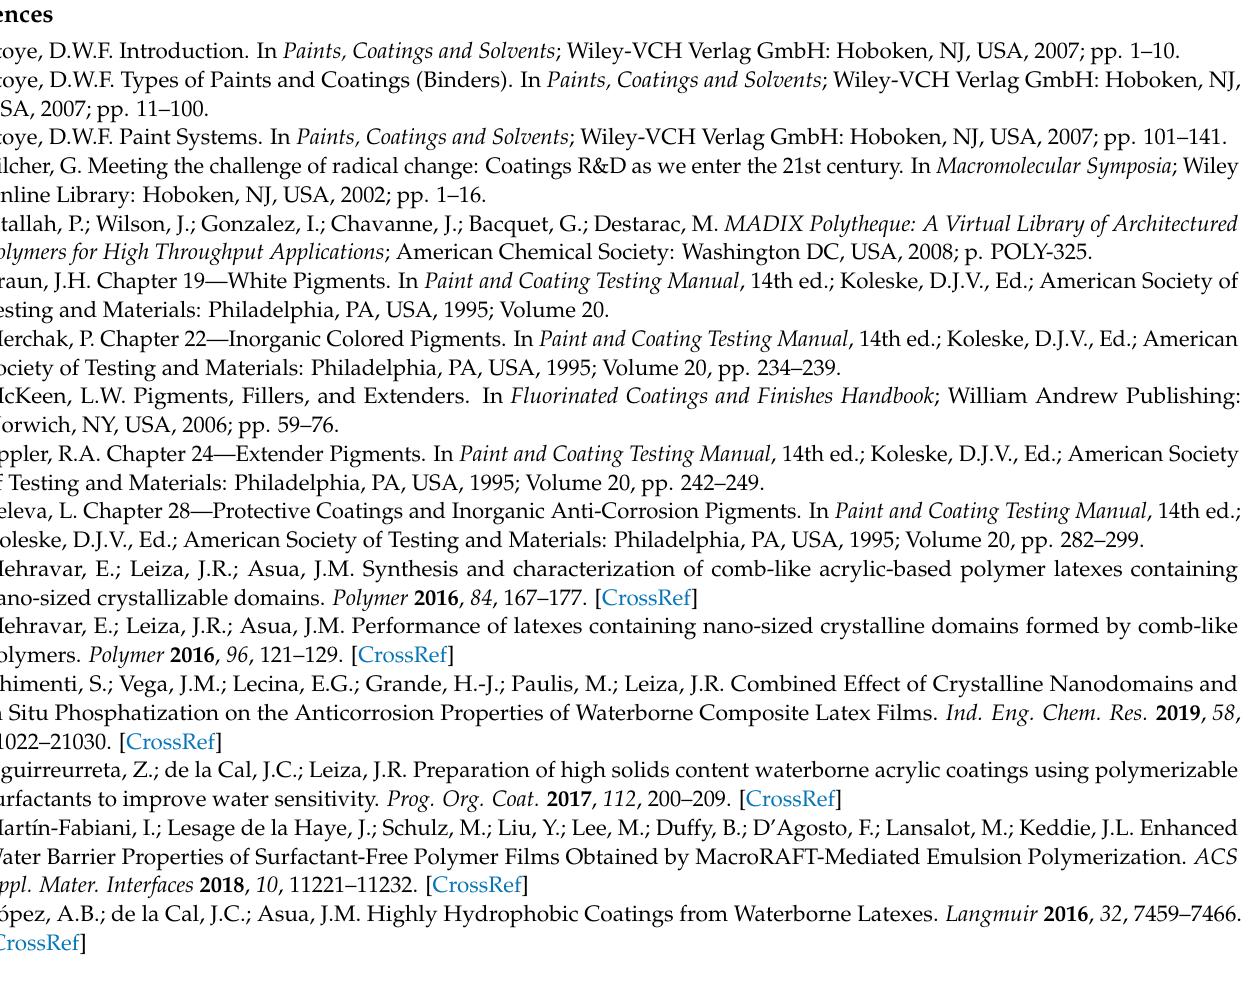
Table S3: Batch mini-emulsion polymerization recipes used to prepare the seeds, Table S4: Seeded semi-batch emulsion polymerization recipes used, Table S5: Particle size (dp), the final solids content (SC), the minimum film formation temperature (MFFT), glass transition temperature (Tg), melting temperature (Tm), heat of fusion ( ∆ Hf) and crystallinity (Xc) of the synthesized latexes. Author Contributions: Conceptualization, M.P. and J.R.L.; methodology, S.C.; validation, M.C.